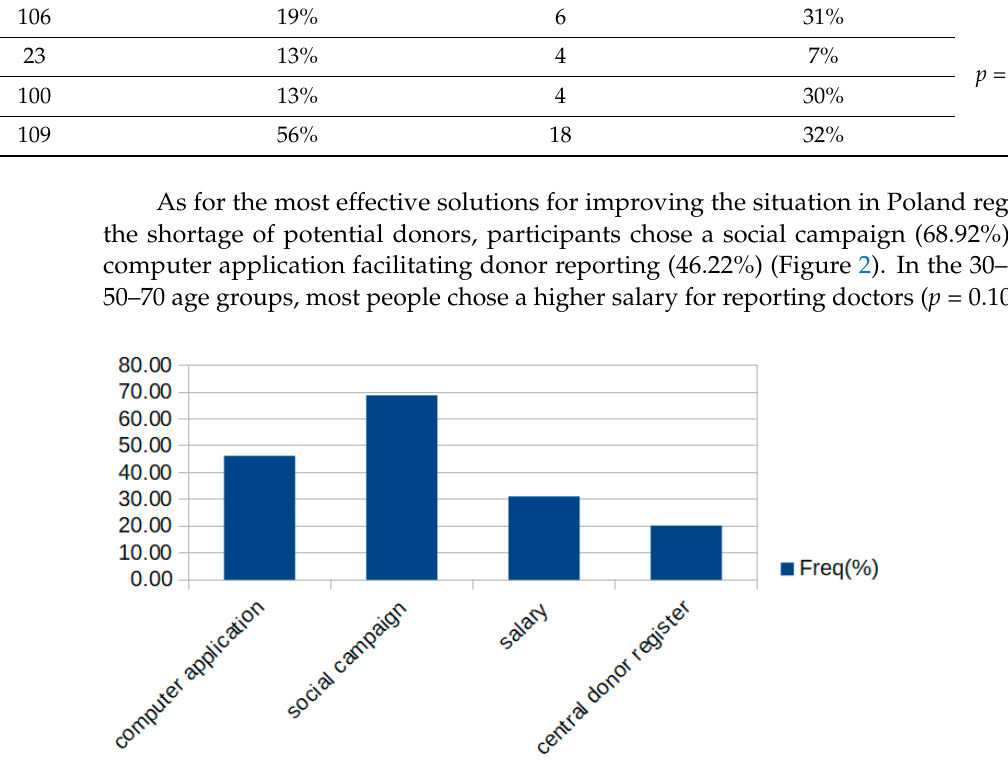
Figure 2. The most effective solutions for improving the situation in Poland.